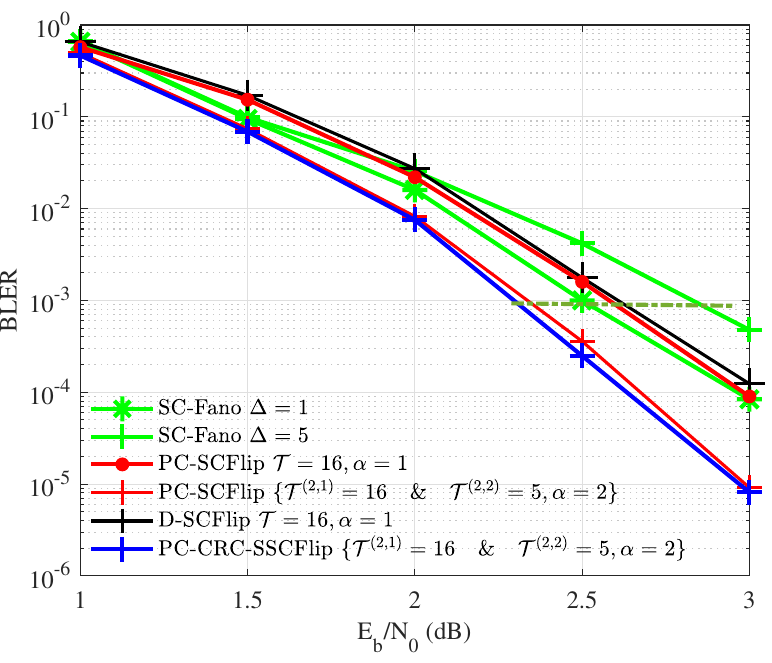
Figure 9. BLER performance of the PC-CRC-SSCFlip decoder compared with SC-Fano, D-SCFlip, and PC-SCFlip decoders for P ( 1024,512 ) with 24 check